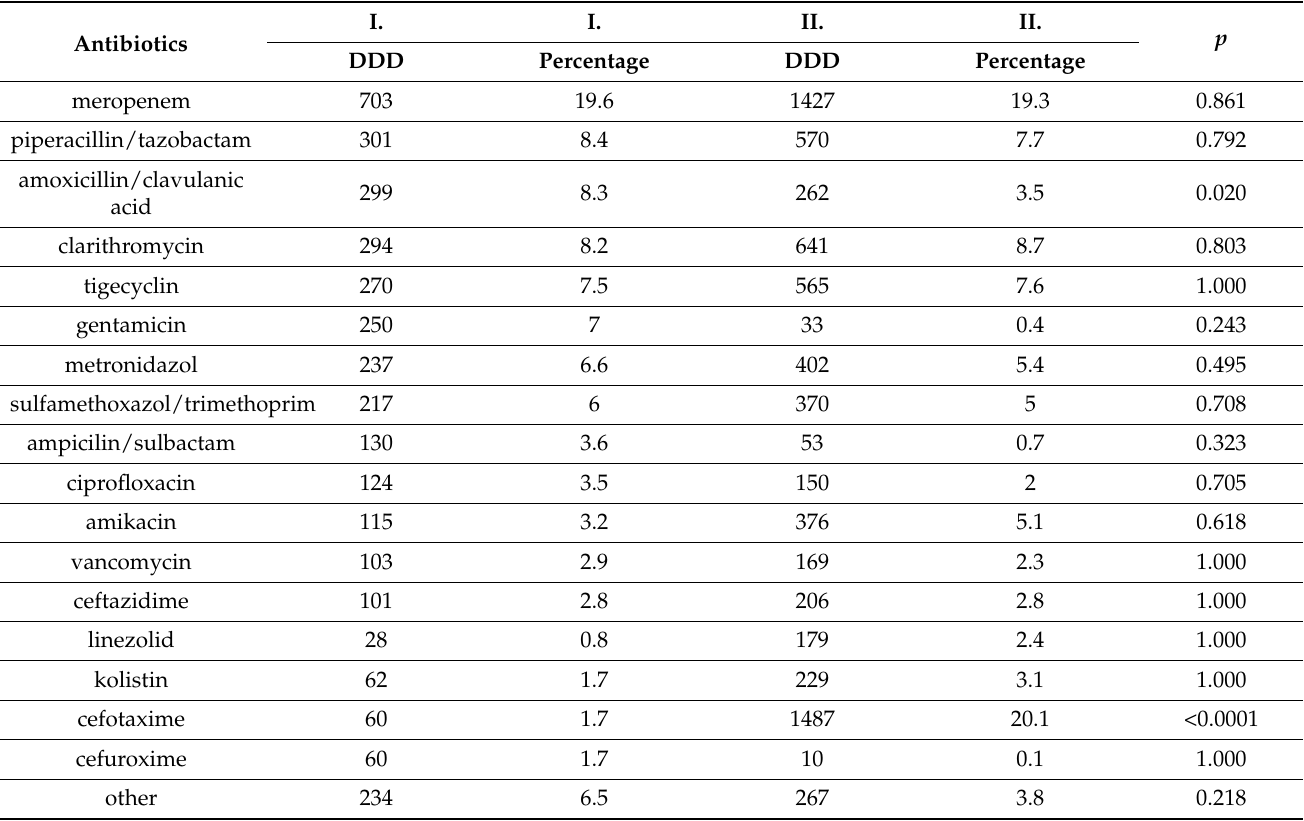
Table 4. Consumption of antibacterial agents before (I) and during (II) the COVID-19 pandemic in DDD and as percentage of individual antibiotics in total